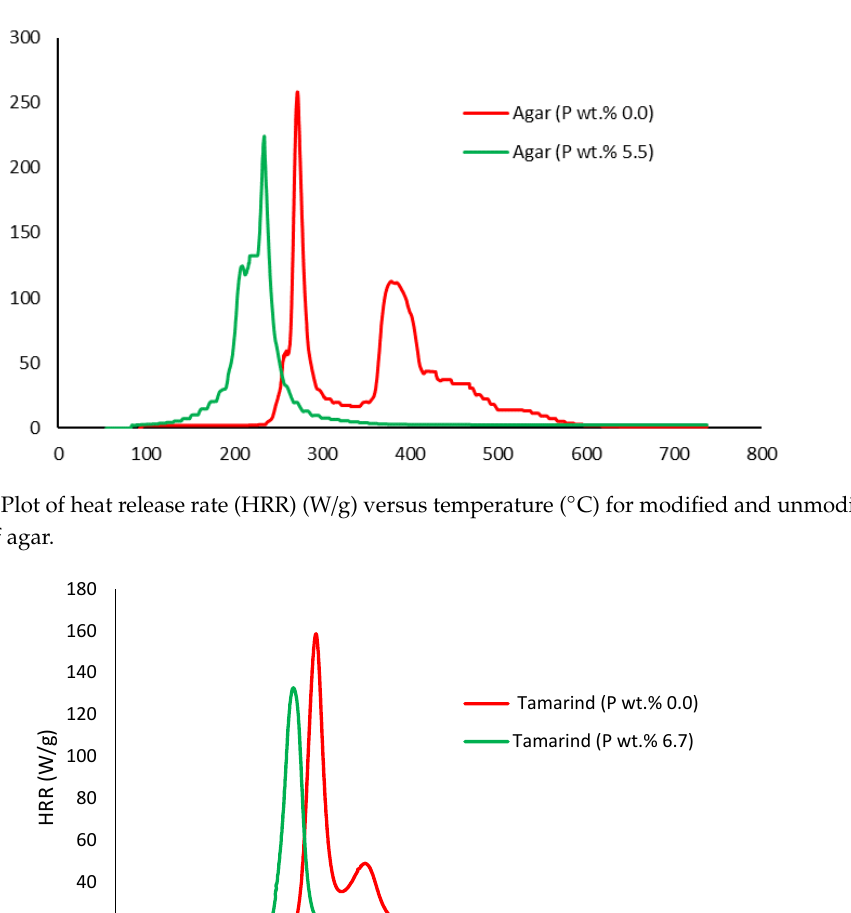
Figure 10. Plot of heat release rate (HRR) (W/g) versus temperature (°C) for modified and unmodified versions of potato starch.